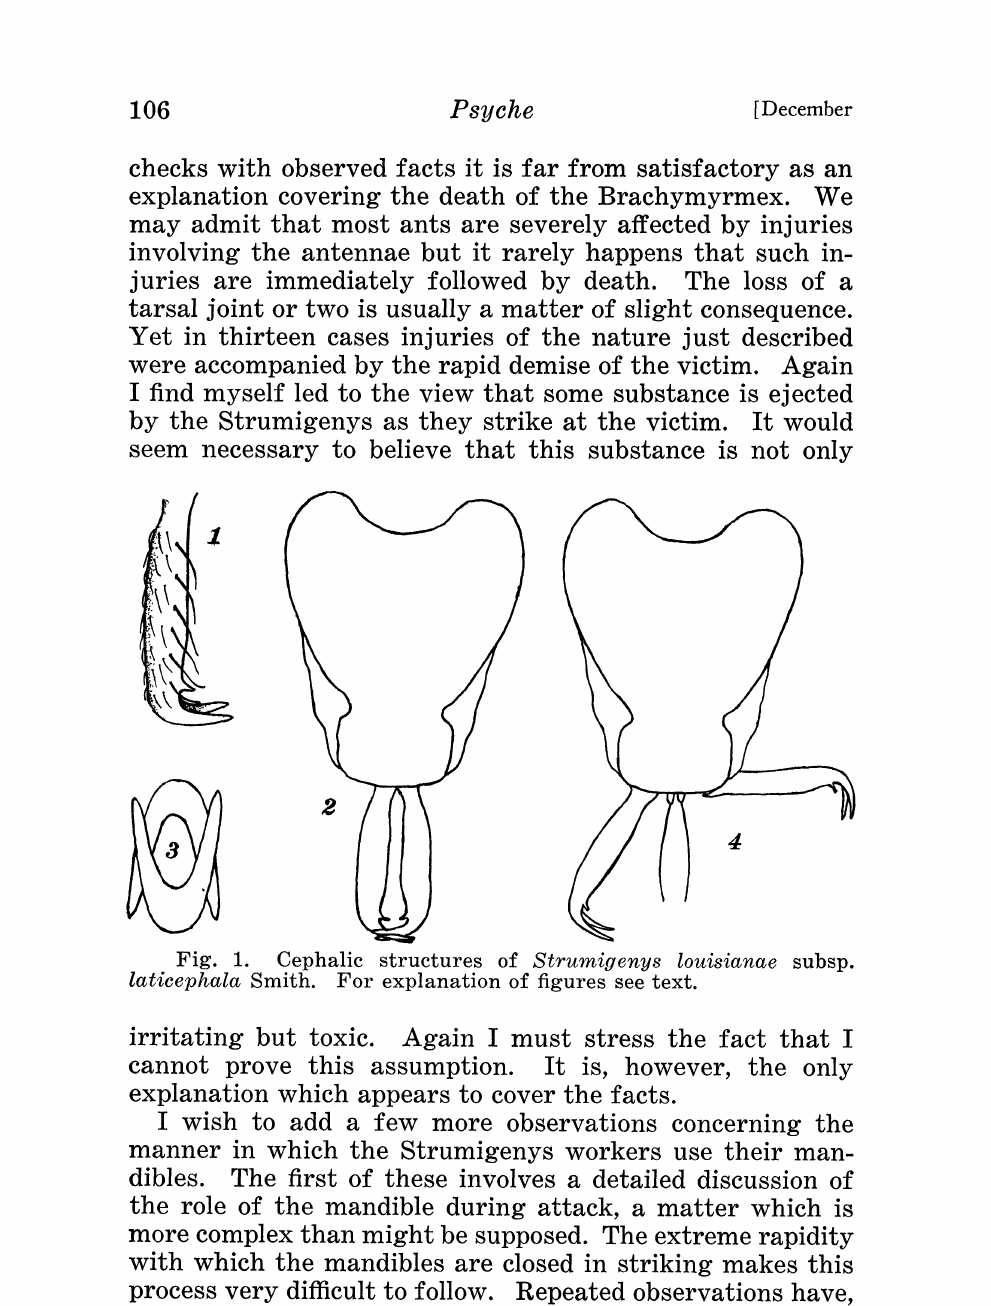
Fig. 1. Cephalic structures of Strumigenys louisianae subsp. laticephala Smith. For explanation of figures see text. irritating but